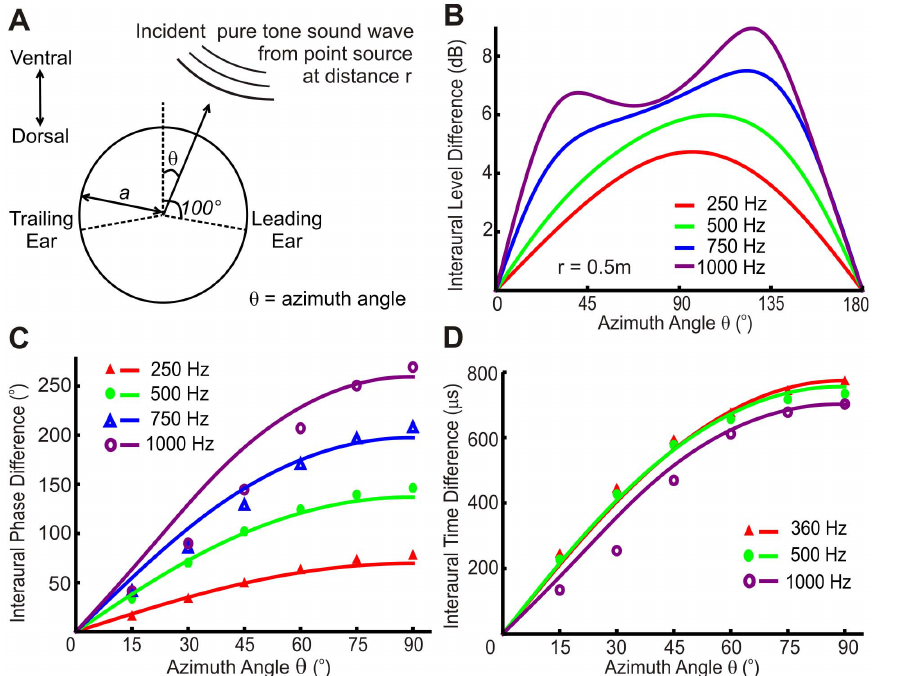
Figure 1. Model predictions for human ILDs and ITDs. A , Model to determine ITD or ILD variation with azimuth angle h for the experimental set up in Mills [15], Schmidt et al. [16] and Kuhn [14]. The human head is modelled as a solid sphere, radius a (8.75 cm) and the sound source is modelled as a point source, frequency f, and distance r from the centre of the head. Ears are positioned 100 u away from the midline. B , Azimuthal variation of interaural level difference (ILD) for sound source at 0.5 m, 250 Hz, 500 Hz, 750 Hz or 1000 Hz, as predicted by our acoustic model for the experimental set up by Mills. C , Comparison of predicted curves for interaural phase differences (IPDs) and empirical data points from Mills [15], r=0.5 m. D , Comparison of model interaural time differences (ITDs) with empirical data from Kuhn [14], r=3.0 m.